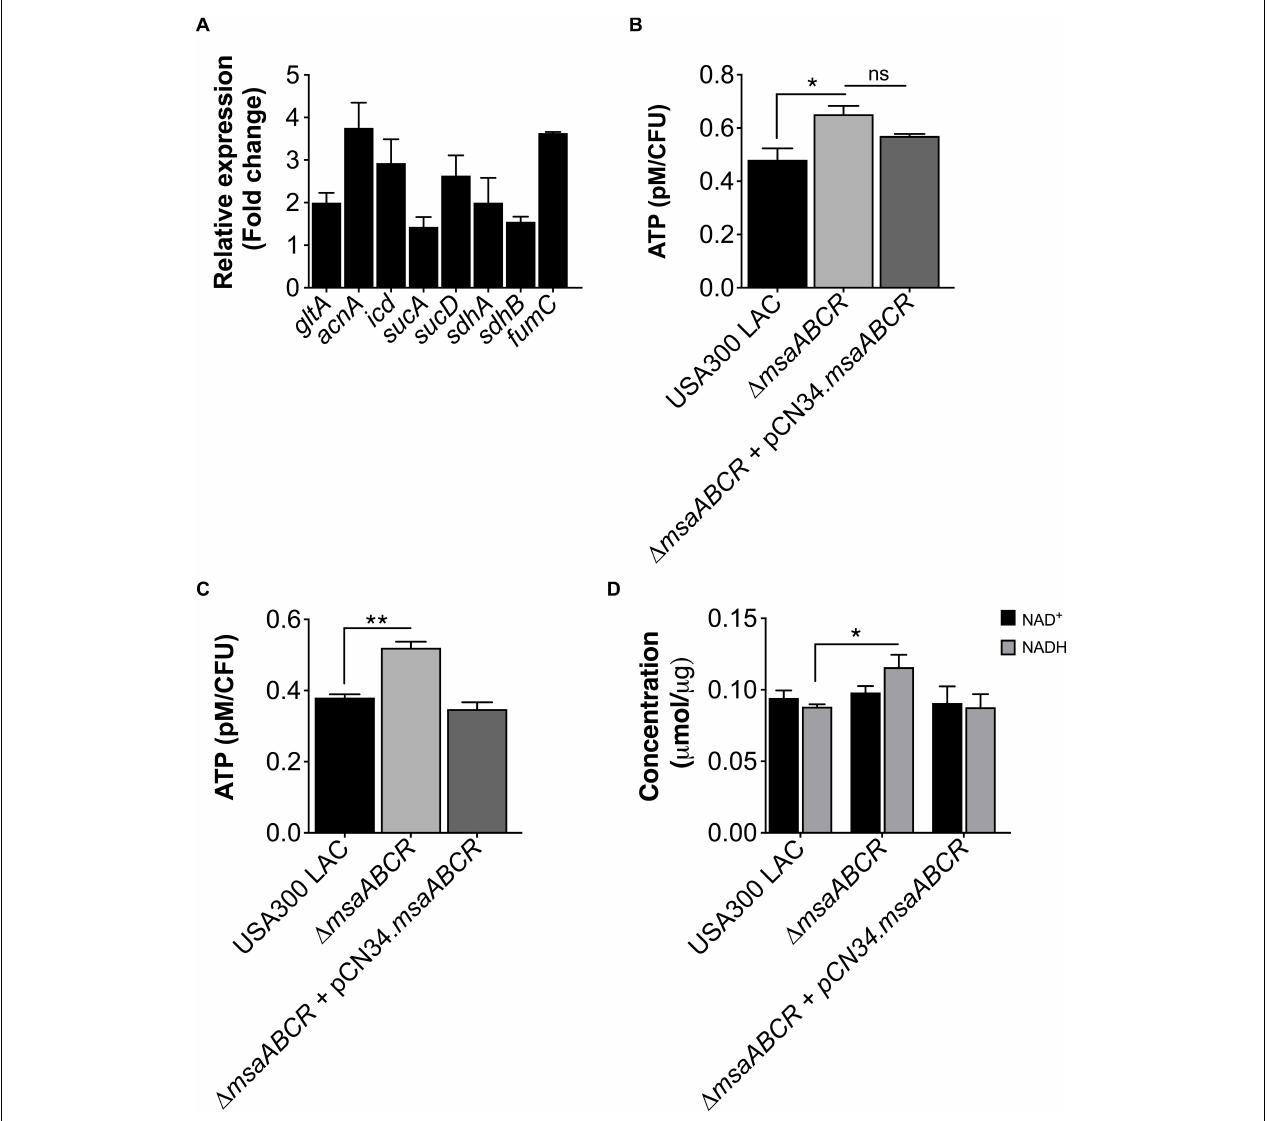
FIGURE 1 | Measurement of TCA cycle activity, intracellular ATP level, and NAD + /NADH content. (A) Fold change expression of TCA genes ( gltA , acnA , icd , sucA , sucD , sdhA/B , and fumC ) in late exponential growth phase for the (cid:77) msaABCR compared with the USA300 LAC strain, as measured by qRT-PCR. (B) The ATP concentrations per CFU of all strains were measured in late exponential and (C) stationary growth phases. The data represent the average of three ATP concentrations per CFU for each individual sample measured with two biological replicates. (D) Absolute concentration of NAD + /NADH content in all strains grown to late exponential phase. Error bars represent the standard error of the mean (SEM) for three independent experiments. Statistical significance was determined using analysis of variance (ANOVA) followed by Tukey’s multiple comparison test. *, P ≤ 0.05; **, P ≤